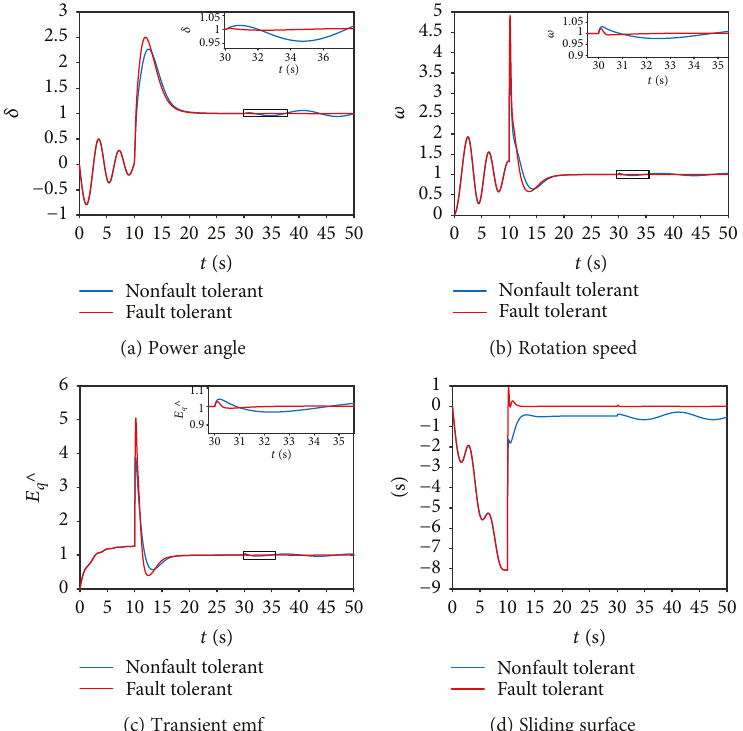
Figure 2: Simulation